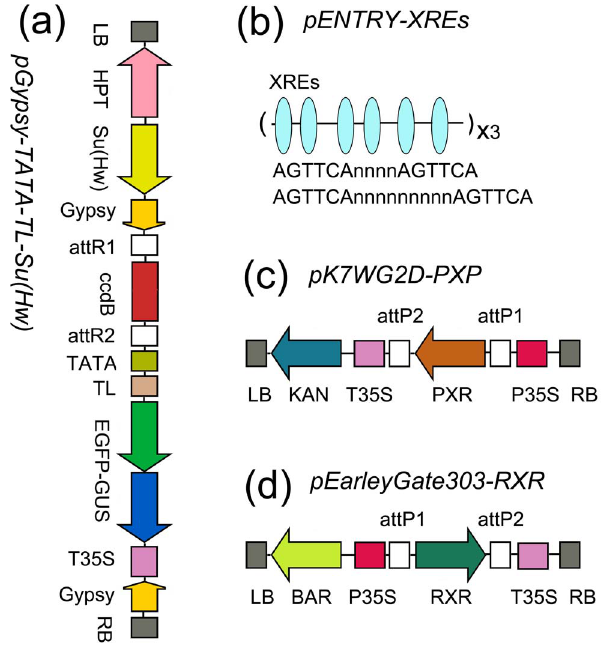
Figure 1. Construction of T-DNA vectors carrying the mouse PXR (pregnane X receptor) system. (a) pGypsy-TATA-TL-Su(Hw) was a destination vector for enhancer analysis which was constructed based on pGypsy-TL-Su(Hw) (She et al. , 2010). The positions and orientations of the selectable marker gene HPT (hygromycin phospho- transferase) and the reporter gene EGFP-GUS (Enhance Green Fluores- cent Protein plus b -glucuronidase) are shown with respect to the left border (LB) and right border (RB) of the T-DNA regions. The ccdB region was expected to be replaced by an enhancer sequence by a LR reaction. A 35S CaMV mini promoter ( 2 46 to 0, TATA) together with a translation leader (TL) region from pH 7WG2D (Karimi et al. , 2002) were inserted upstream the reporter gene. (b) Schematic overview of the